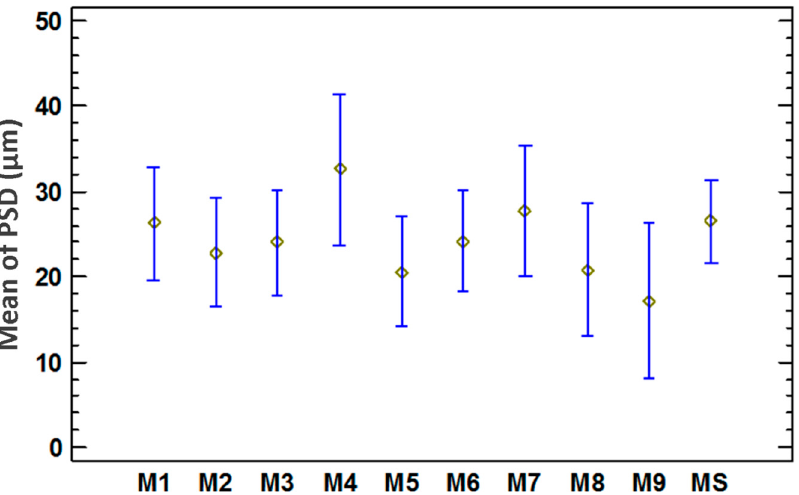
Figure 8. Tukey’s HDS plot for comparison of PSD between optical microscopy (M1…M9) and laser diffraction technique (MS) for the CuCN sample.